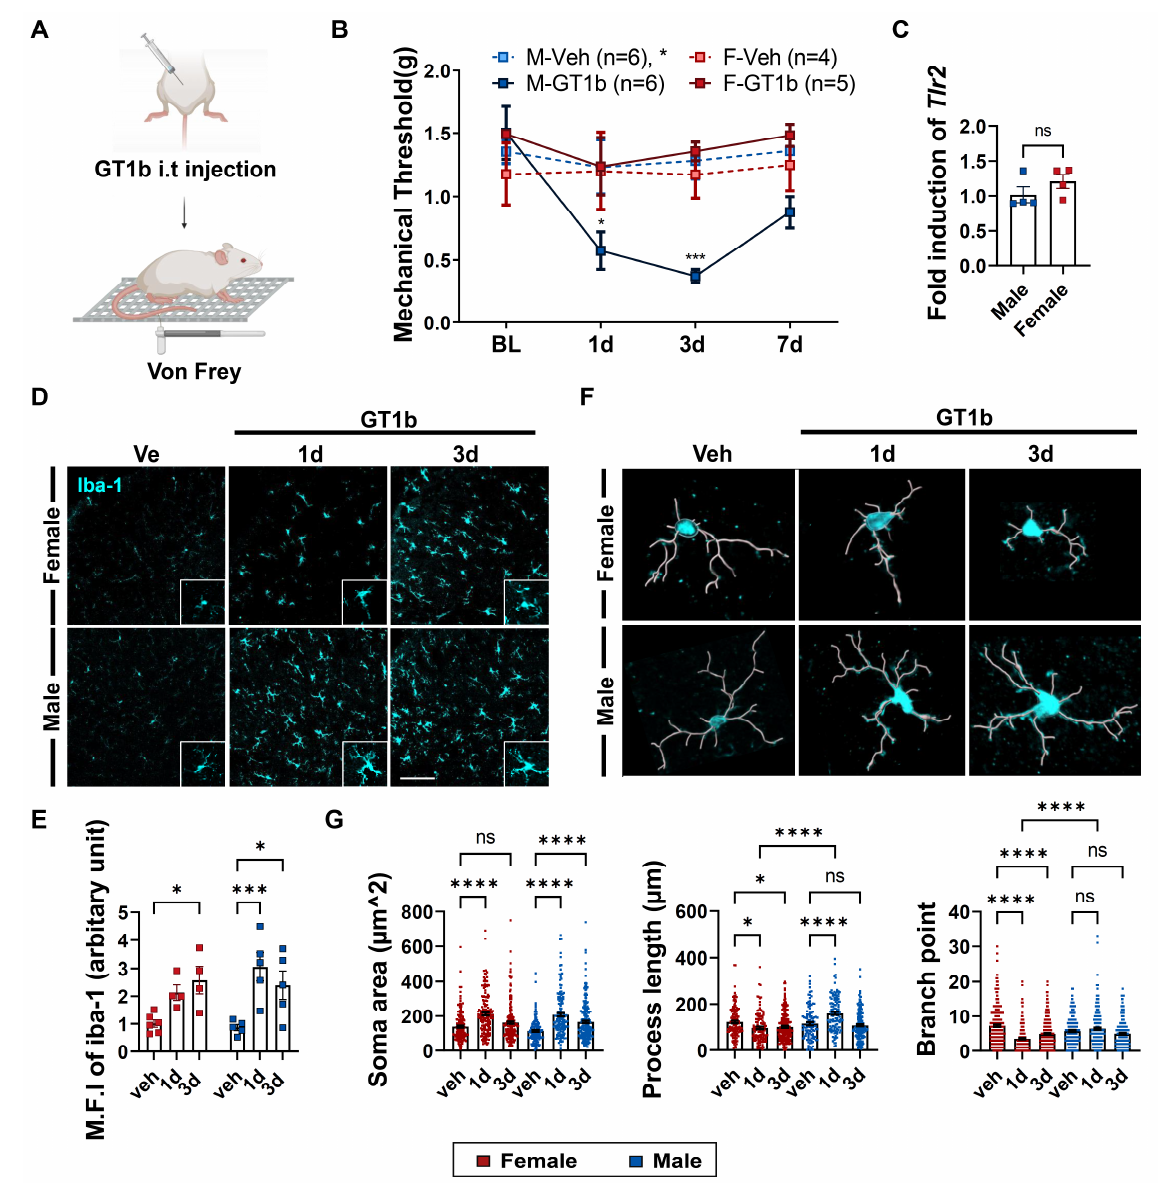
Figure 1. Characterization of GT1b-induced central pain sensitization and GT1b-induced microglial activation. ( A ) Schematic diagram of i.t administration of GT1b and von Frey allodynia test. ( B ) Mechanical threshold of von Frey tests on hind paws after GT1b administration (n = 4 to 6/group,